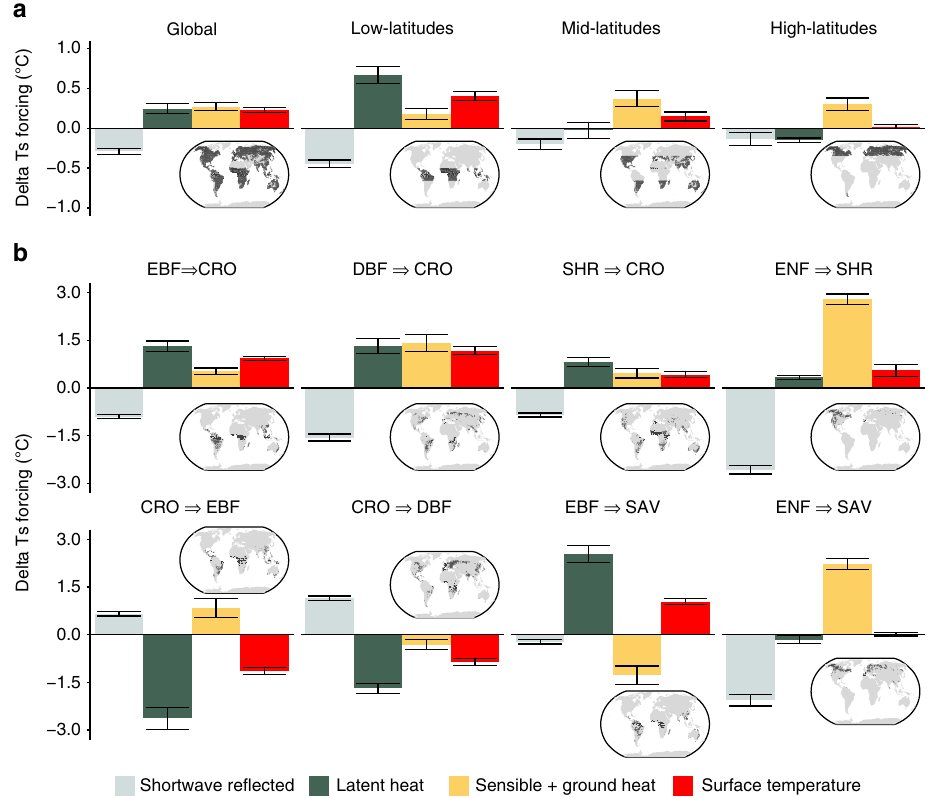
Fig. 6 Changes in surface temperature resulting from major vegetation transitions between 2000 and 2015. The bars represent the respective contribution of each component of the surface energy balance to the change in surface temperature (Ts). a Illustrates changes at global scale or divided by broad latitudinal bands, while b shows changes for a selection of transitions types involving the following vegetation classes: evergreen broadleaf forests (EBF), deciduous broadleaf forests (DBF), evergreen needleleaf forests (ENF), savannas (SAV), shrublands (SHR) and croplands (CRO). Each bar represents the mean of all changed pixels weighted by the actual change within each 1° pixel. The errorbars represent ± two times the weighted standard error around